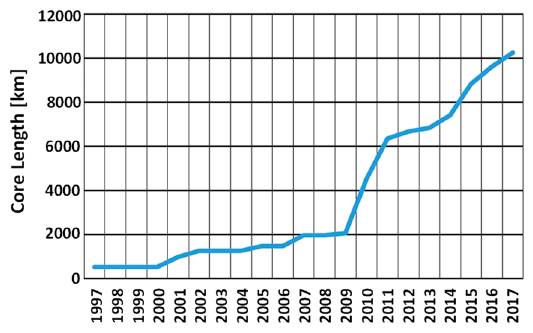
Figure 1. the core length of DC-XLPE cables installed and under construction in year 2018 (Figure reprinted with permission from CIGRE Session Paper B1-309, Jeroense, M.; Bergelin, P.; Quist, T.; Abbasi, A.; Rapp, H.; Wang, L. Fully Qualified 640 kV Underground Extruded DC Cable System ; CIGRE: Paris, France, 2018, © 2018).